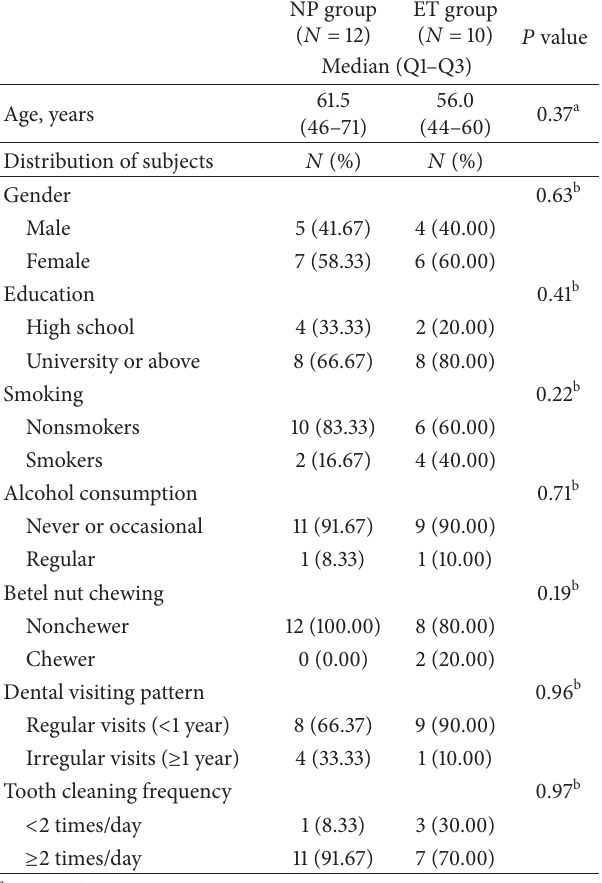
Table 1: Demographic characteristics and conventional periodonti- tis risk factors of study subjects by treatment outcome strata.